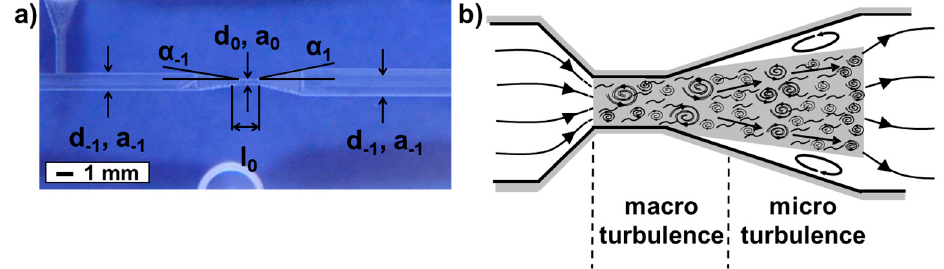
Figure 2. ( a ) Characteristic geometrical parameters of the micronozzle; ( b ) turbulent field in diverging nozzle section. Dissipation volume is marked grey and regions of macro and micro turbulence are given.